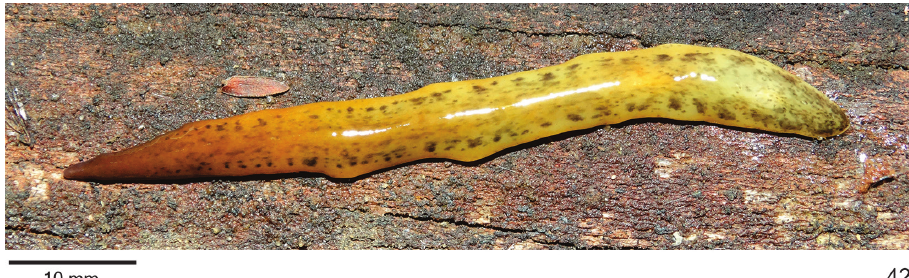
Figure 42. Cratera aureomaculata sp. n., holotype, habitus, dorsal Table 5. Measurements, in mm, of the holotype of Cratera aureomaculata sp. n. Abbreviations: * after fixation; DG distance of gonopore from anterior end; DM distance of mouth from anterior end; DMG distance between mouth and gonopore; DPVP distance between prostatic vesicle and pharyngeal pouch. The numbers given in parentheses represent the position relative to body length.